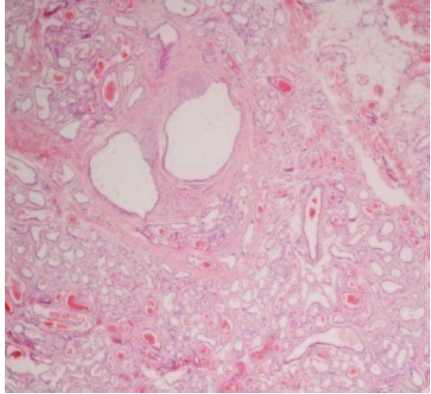
Figure 5: Presence of dilated tubular formations covered by an endothelial layer containing red blood cells, surrounded by thick fibrous connective tissue, was demonstrated (H-E,